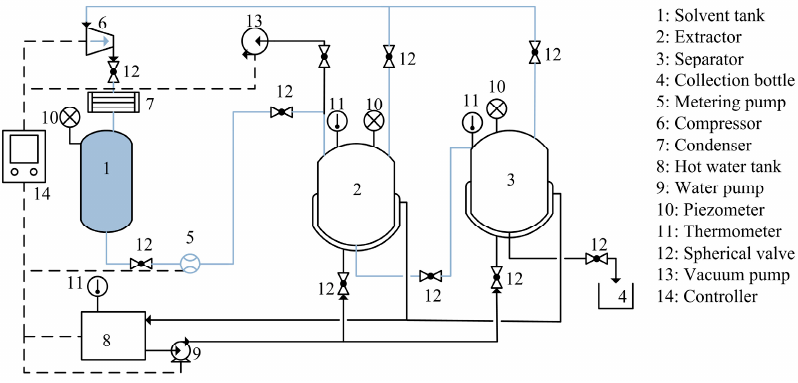
Figure 4. Schematic diagram of the SBE process.